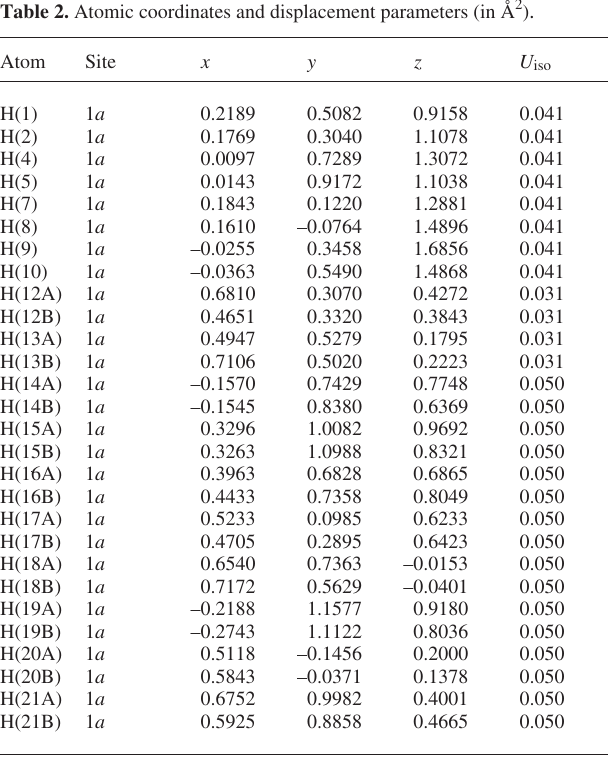
Table 2. Atomic coordinates and displacement parameters (in Å 2 )